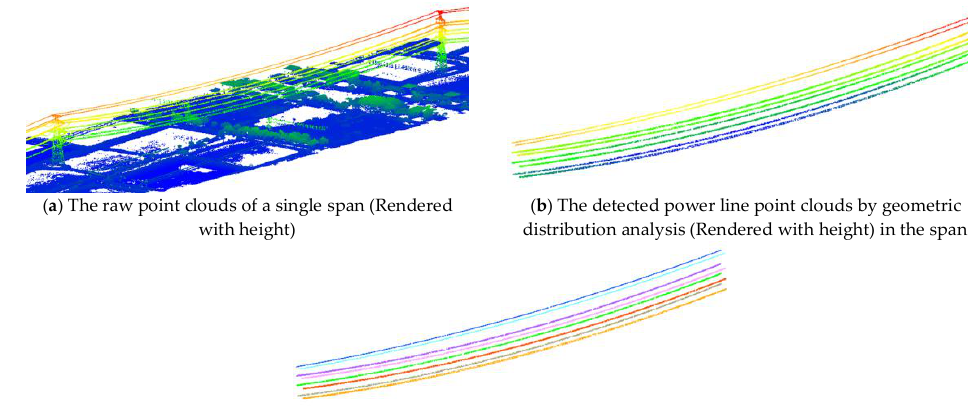
Figure 3. Power line point clouds extraction.